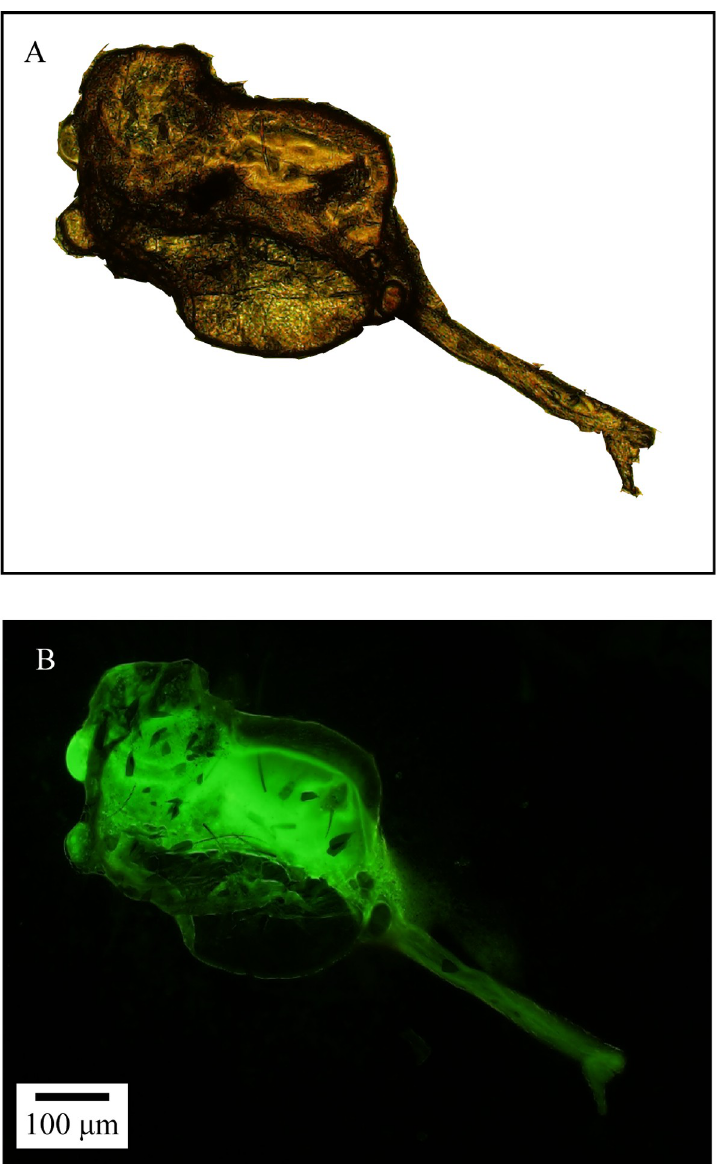
Fig 4. Visualization of GFP-tagged Serratia oryzae was successfully introduced into Aedes albopictus ’ gut by feeding. Bright-field images (A) and the corresponding fluorescent images (B).